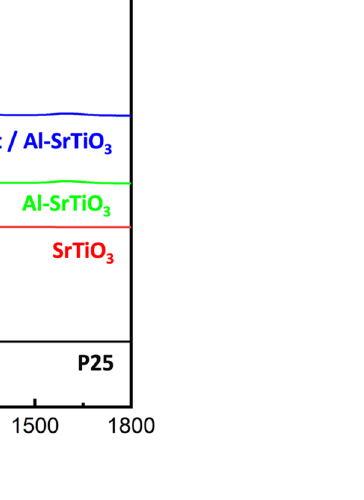
Figure 2. Raman analysis of the investigated samples.